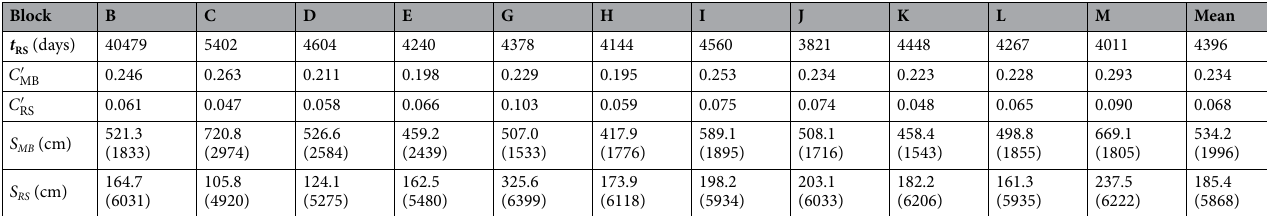
Table 2. The starting date for the residual settlement ( t RS ), compression ratio coupling mechanical creep and bio-compression ( C ′ MB ), compression ratio of residual settlement ( C ′ RS ) for each block in landfill #1, waste settlement coupling mechanical creep and biodegradation ( S MB ), and residual settlement ( S RS ) of MSW in landfill #1 measured after the landfill was closed. The t RS is the date was counted from the time the landfilling was initiated, and the values in parentheses are the durations (days) of each settlement after the landfill was closed.